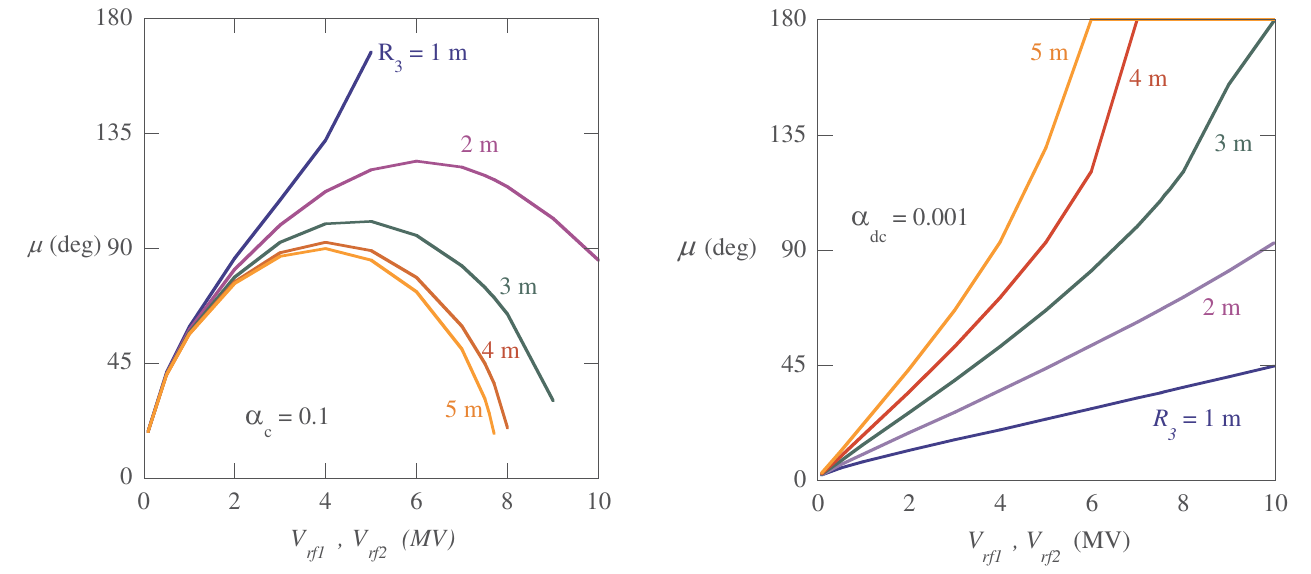
FIG. 12. (Color) Longitudinal phase advance as a function of V in the hypothesis of equal cavities for different longitudinal drift between the cavities and for two different values of a c